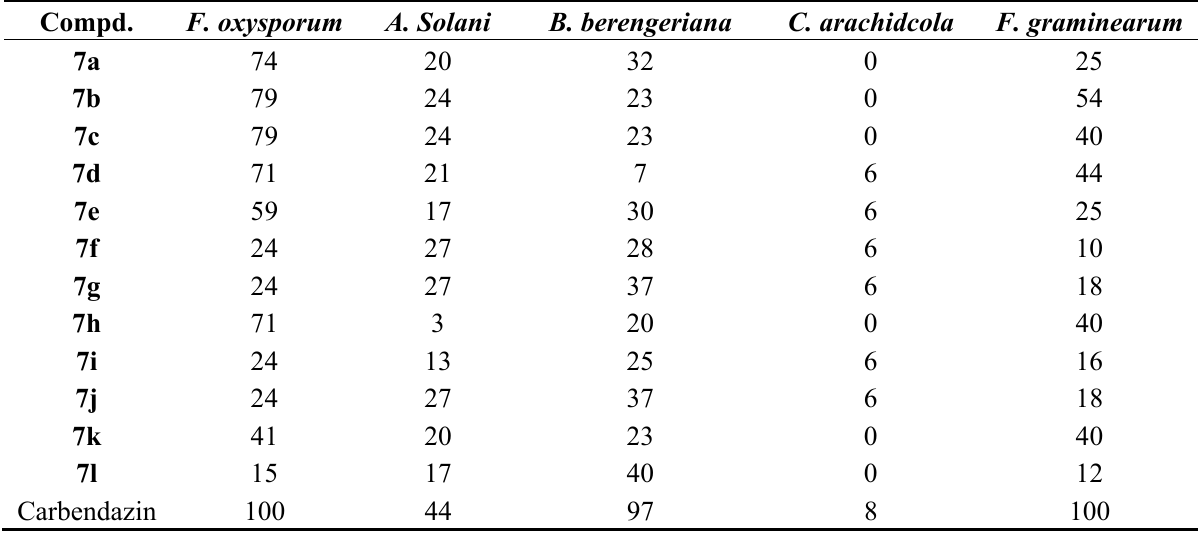
Table 3. The fungicidal activities (inhibition rate, %) of compounds 7 against several plant fungi.